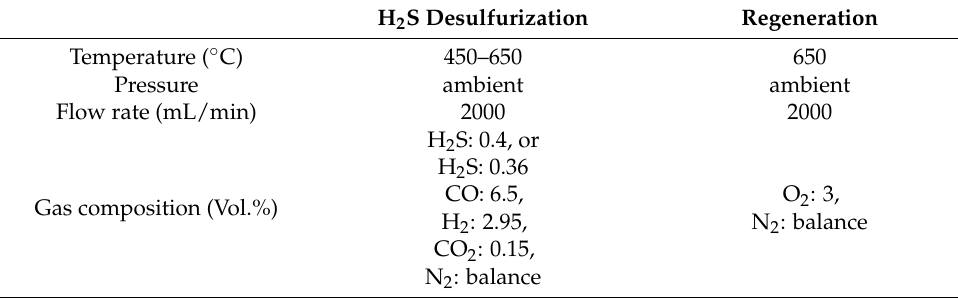
Table 1. Experimental conditions of